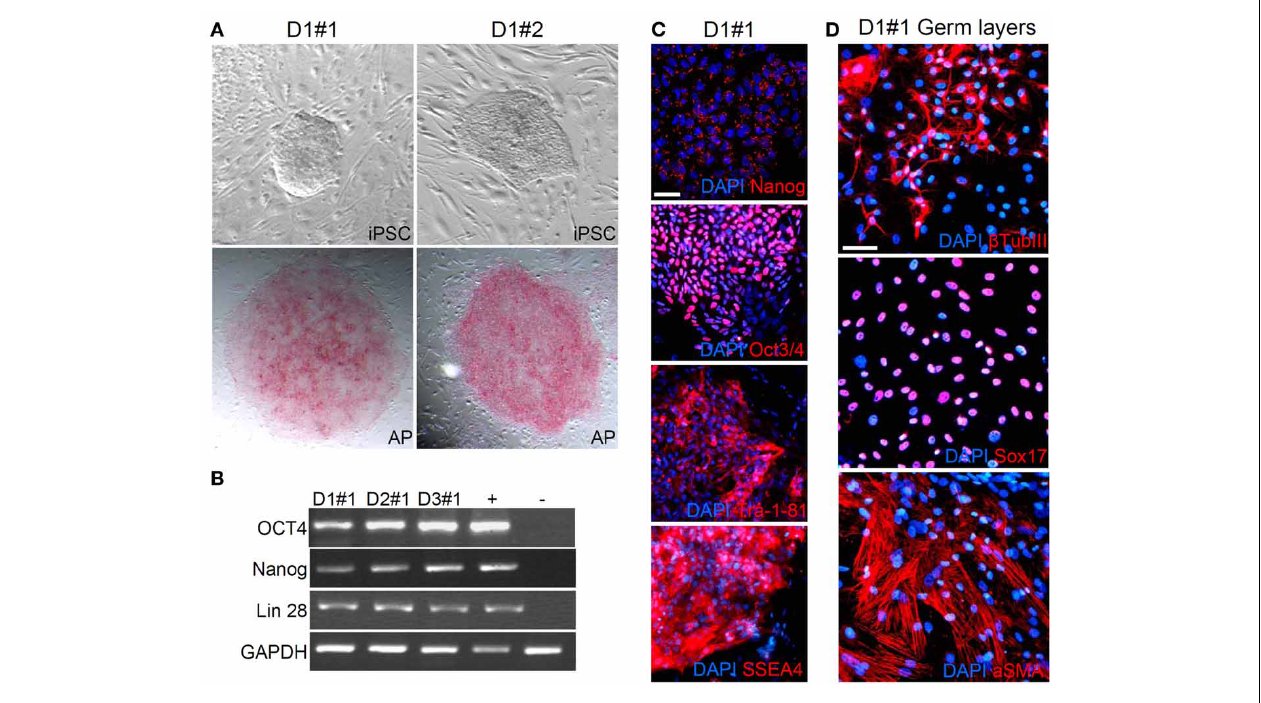
FIGURE 1 | Generation of hiPSC colonies. (A) Representative images of established hiPSC colonies, clones are positive for phosphatase alkaline. (B) and (C) iPSC clones show expression of pluripotency